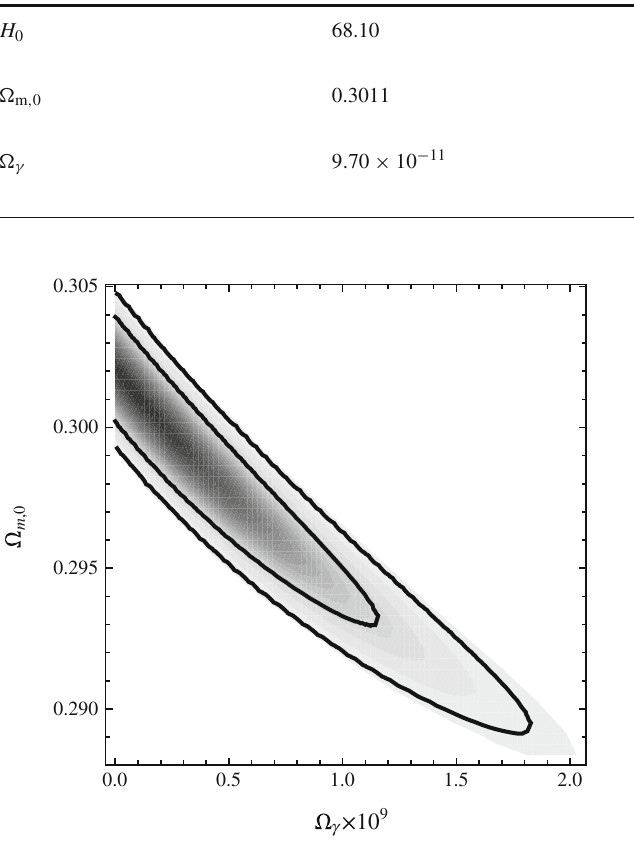
Fig. 17 The intersection of the likelihood functions of two model parameters ( (cid:3) γ , (cid:3) m , 0 ) with the marked 68 and 95% confidence levels